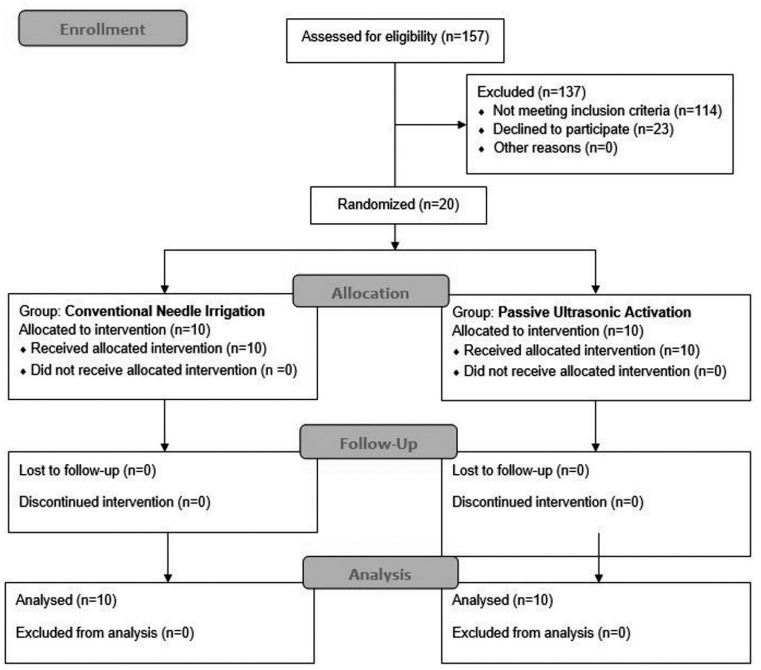
CONSORT flow diagram